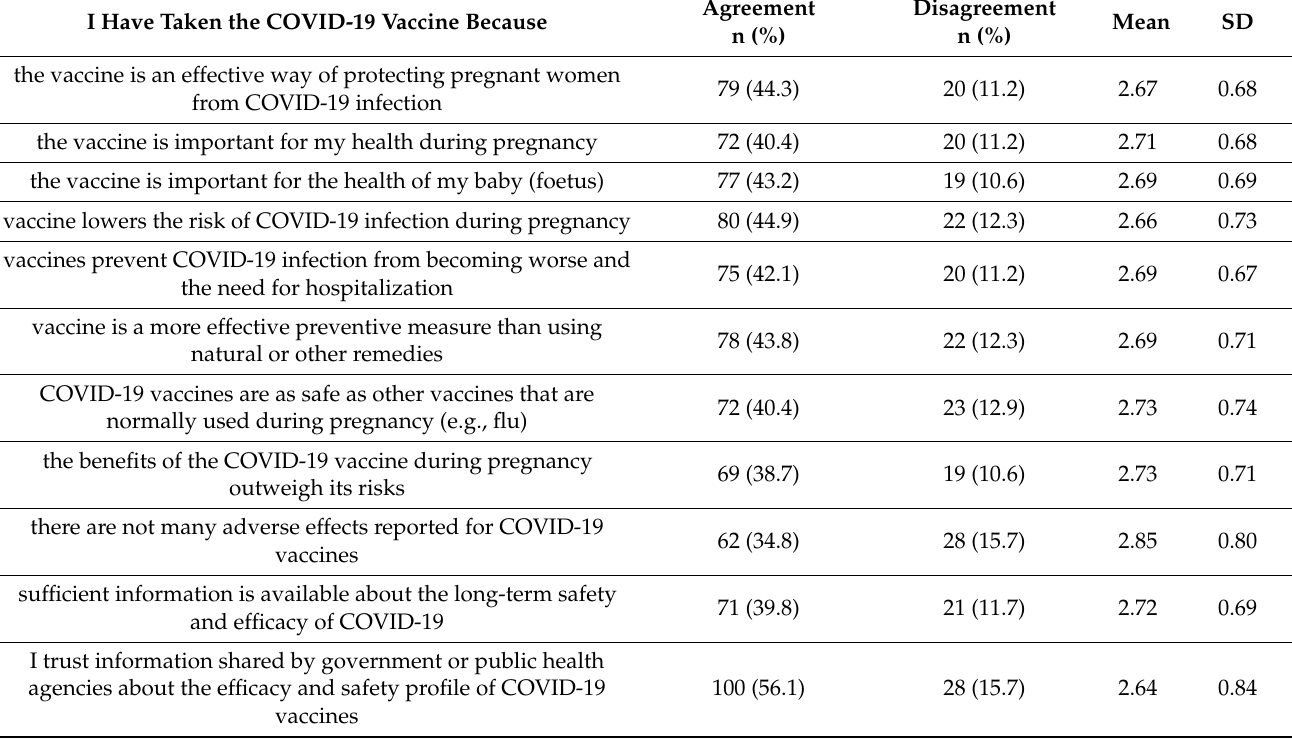
Table 4. Responses to items measuring hesitancy among vaccinated pregnant women (n =